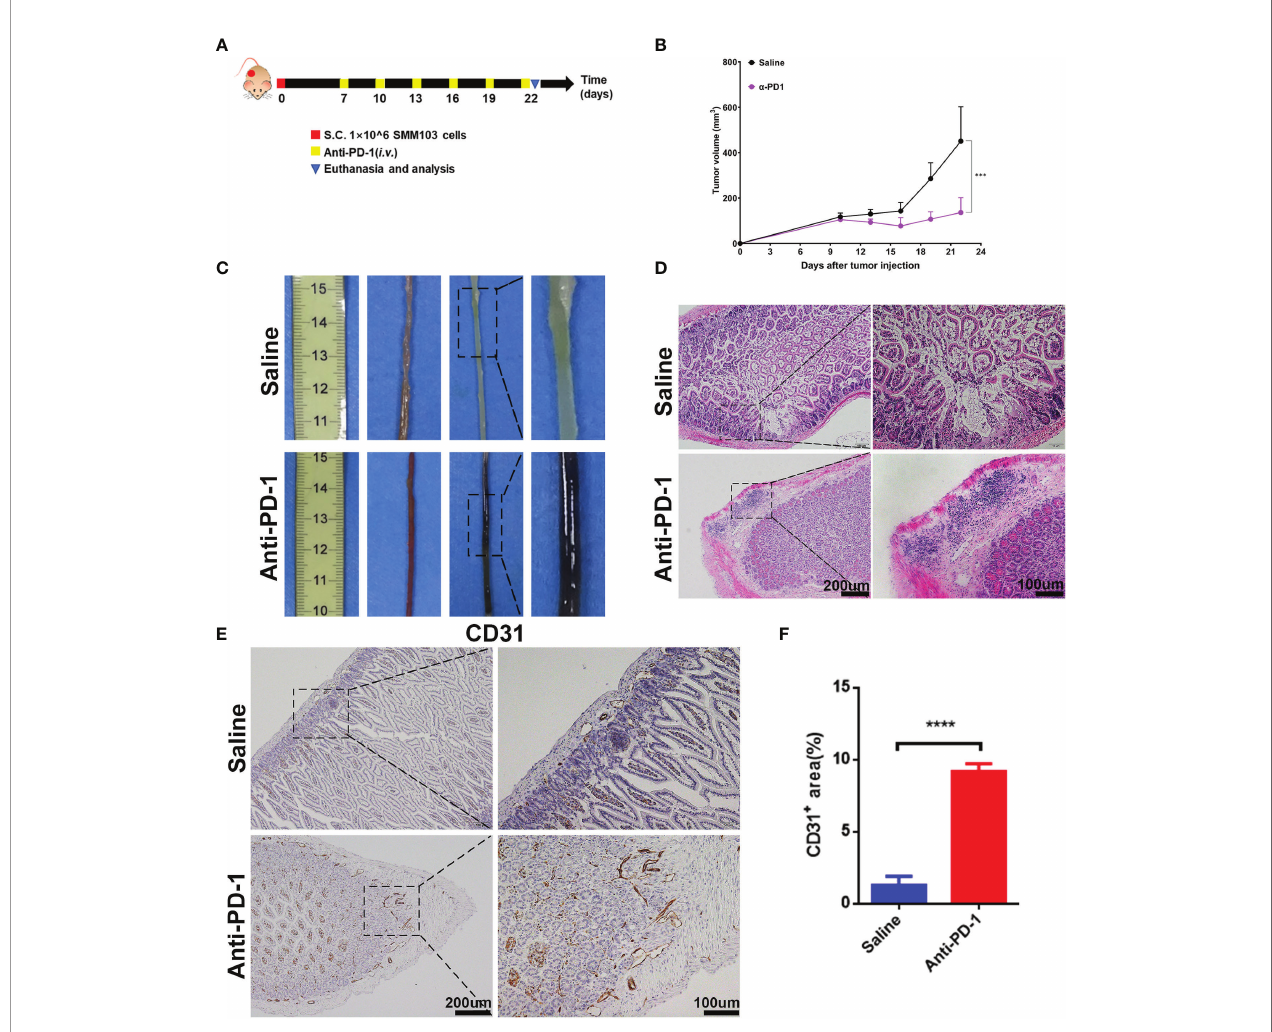
FIGURE 2 | Establishment of irAEs mouse model. (A) Representative diagram showing experimental scheme of establishment of irAEs mouse model. Immune competent C57BL/6 mice were subcutaneously inoculated with 1×10 6 SMM103 melanoma cells on day 0. When tumor volume achieved ≈ 80 mm 3 , mice were treated with saline or anti-PD-1, respectively. Details of treatment are provided in the Methods section. (B) The average tumor growth curves of mice treated with saline and anti- PD-1, respectively. The results are presented as mean ± SD (n=5), *** p < 0.001. (C) Representative intestine from each group after euthanizing the mice on day 22. (D) Lymphatic in fi ltration in intestine detected by staining with hematoxylin and eosin (H&E). Scale bar 200 m m (E) The formation of new blood vascular was visualized by CD31 IHC staining. Scale bar 200 m m. (F) Quantitative results of CD31 positive area. Data was expressed as mean ± SD (n=4), **** p <